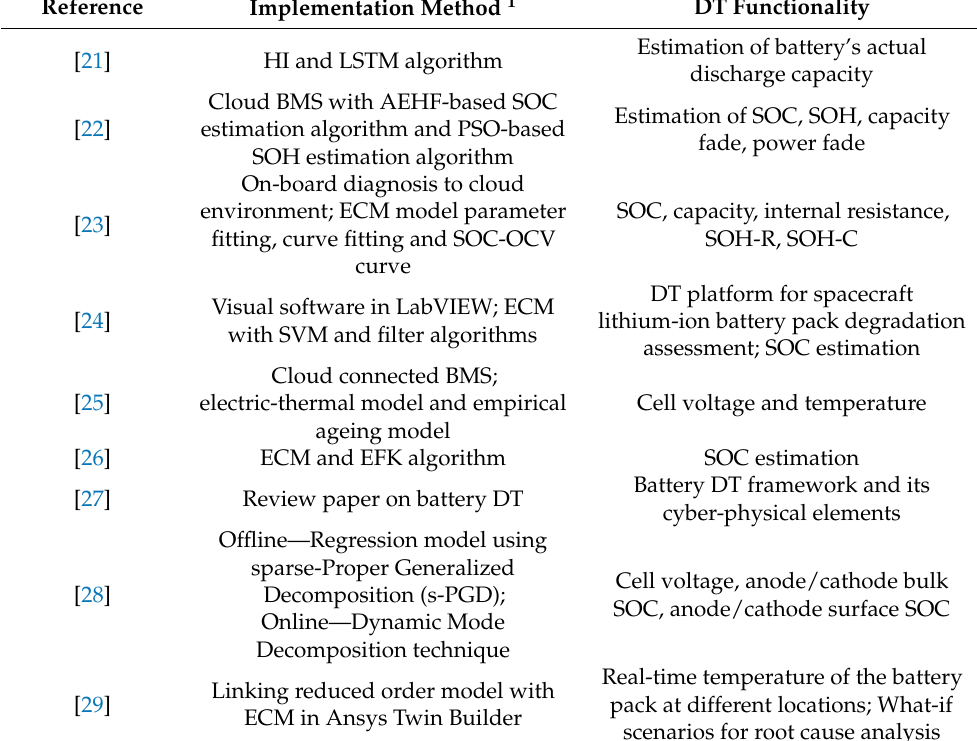
Table 1. Literature review of DT-implementations relevant for battery